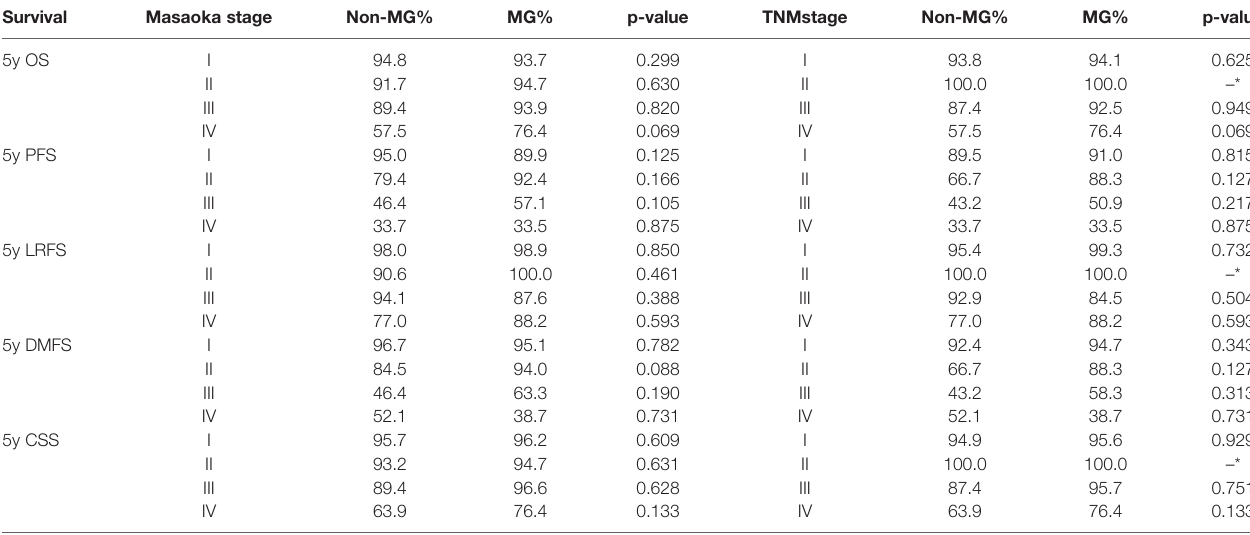
TABLE 2 | Subgroup Analyses. Survival Masaoka stage